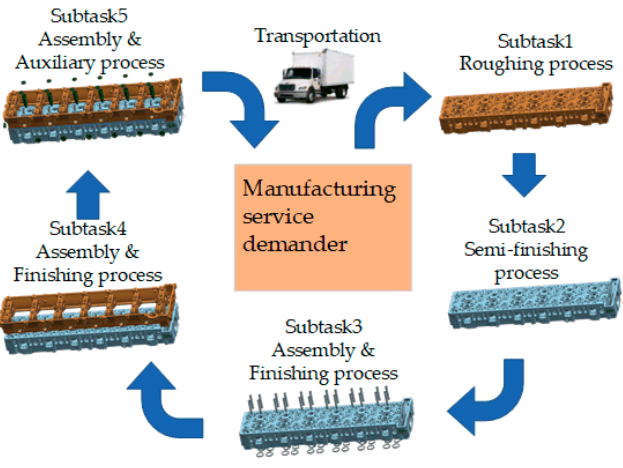
Figure 7. Manufacturing process of natural gas cylinder head. Table 4. The relevant parameters of the candidate outsourcing service resource set.